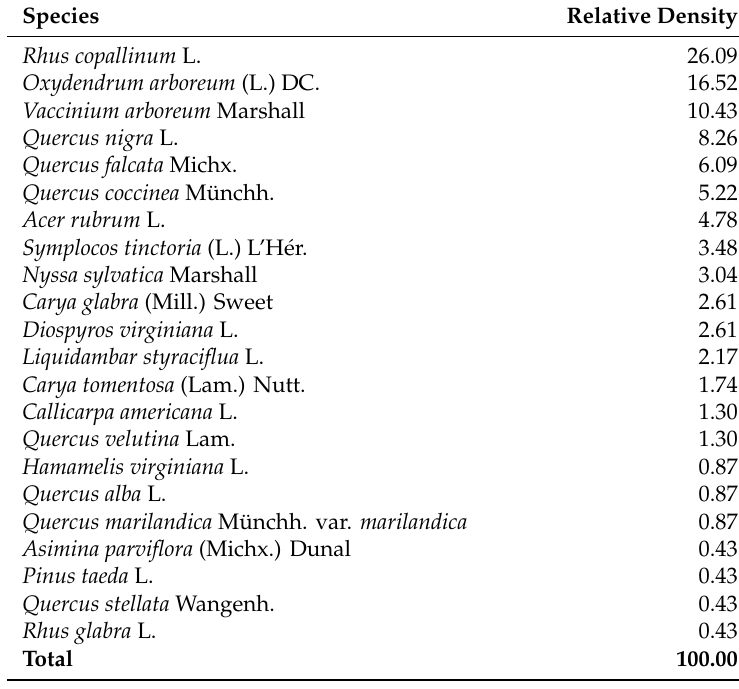
Table 2. Relative density of saplings (live woody stems ≥ 1 m in height, < 5 cm dbh) in a Pinus palustris woodland following catastrophic wind disturbance, ordered by relative